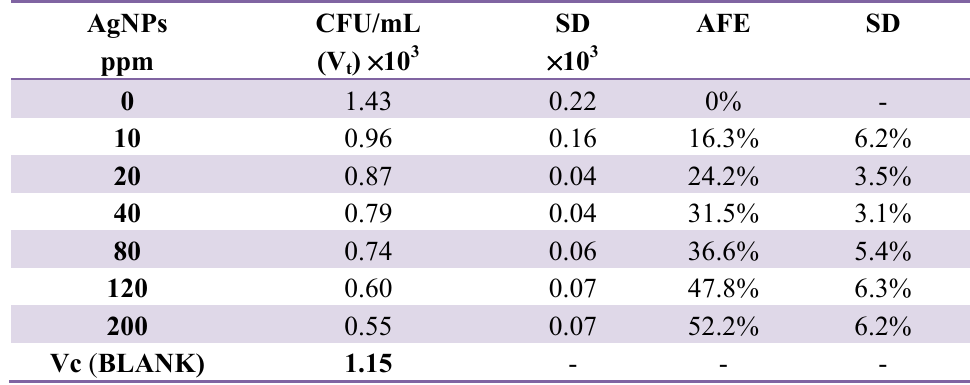
Table 1. The average antifungal effect for UG and UG/AgNP composites against Candida albicans . CFU, colony forming units; AFE, antifungal efficacy; V fungal colonies of the test specimen; SD, standard deviation.